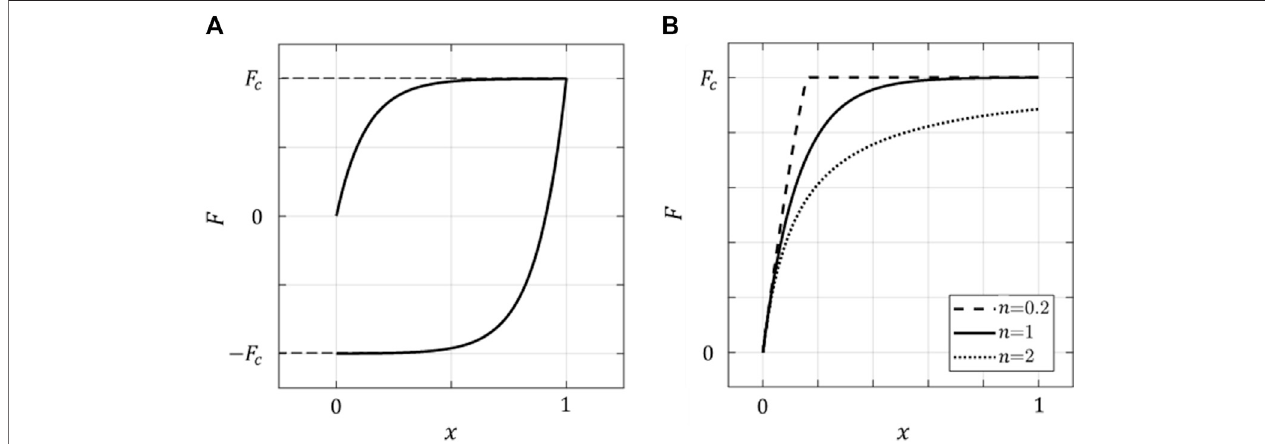
FIGURE 2 | The model of Dahl: (A) Typical function of the frictional force, (B) Shape parameter n.